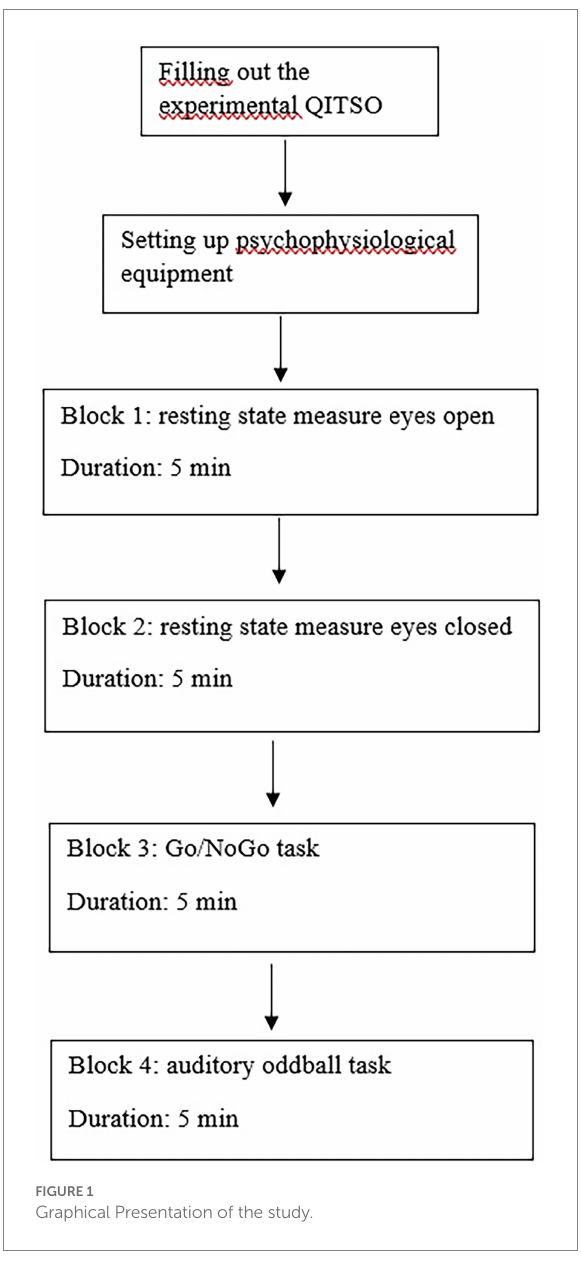
FIGURE 1 Graphical Presentation of the